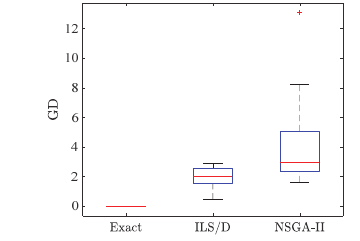
Fig. 5. GD boxplot for exact, ILS/D and NSGA-II algorithms for the A- n37-k5 instance